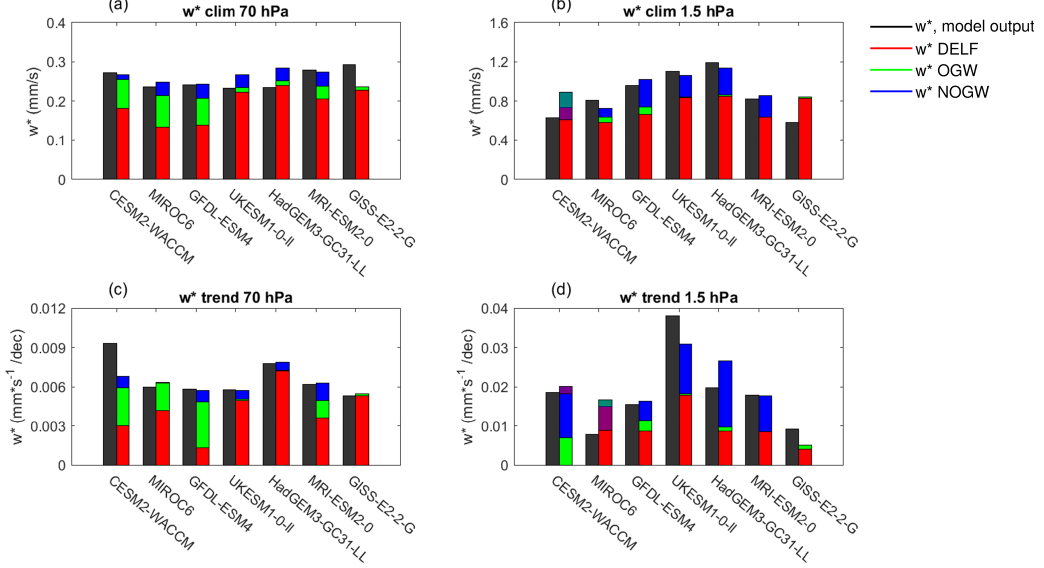
Figure 12. Decomposition into forcing from different waves of the tropical upwelling at 70hPa (a, c) and 1.5hPa (b, d) for the climatology (upper panels) and trends (lower panels) for the separate models, computed over the 150 years of the 1pctCO2 simulations. The black bar shows the upwelling directly from model output. The other colors are as in Fig. 11: red for resolved waves, green for OGWs and blue for NOGWs. The semitransparent shading in panels (b) and (d) indicates a negative contribution from a forcing, plotted from the top down in the corresponding color (e.g., NOGW in panel b for CESM2-WACCM). Note that for the GISS model NOGW output is not available, although these waves are present in the